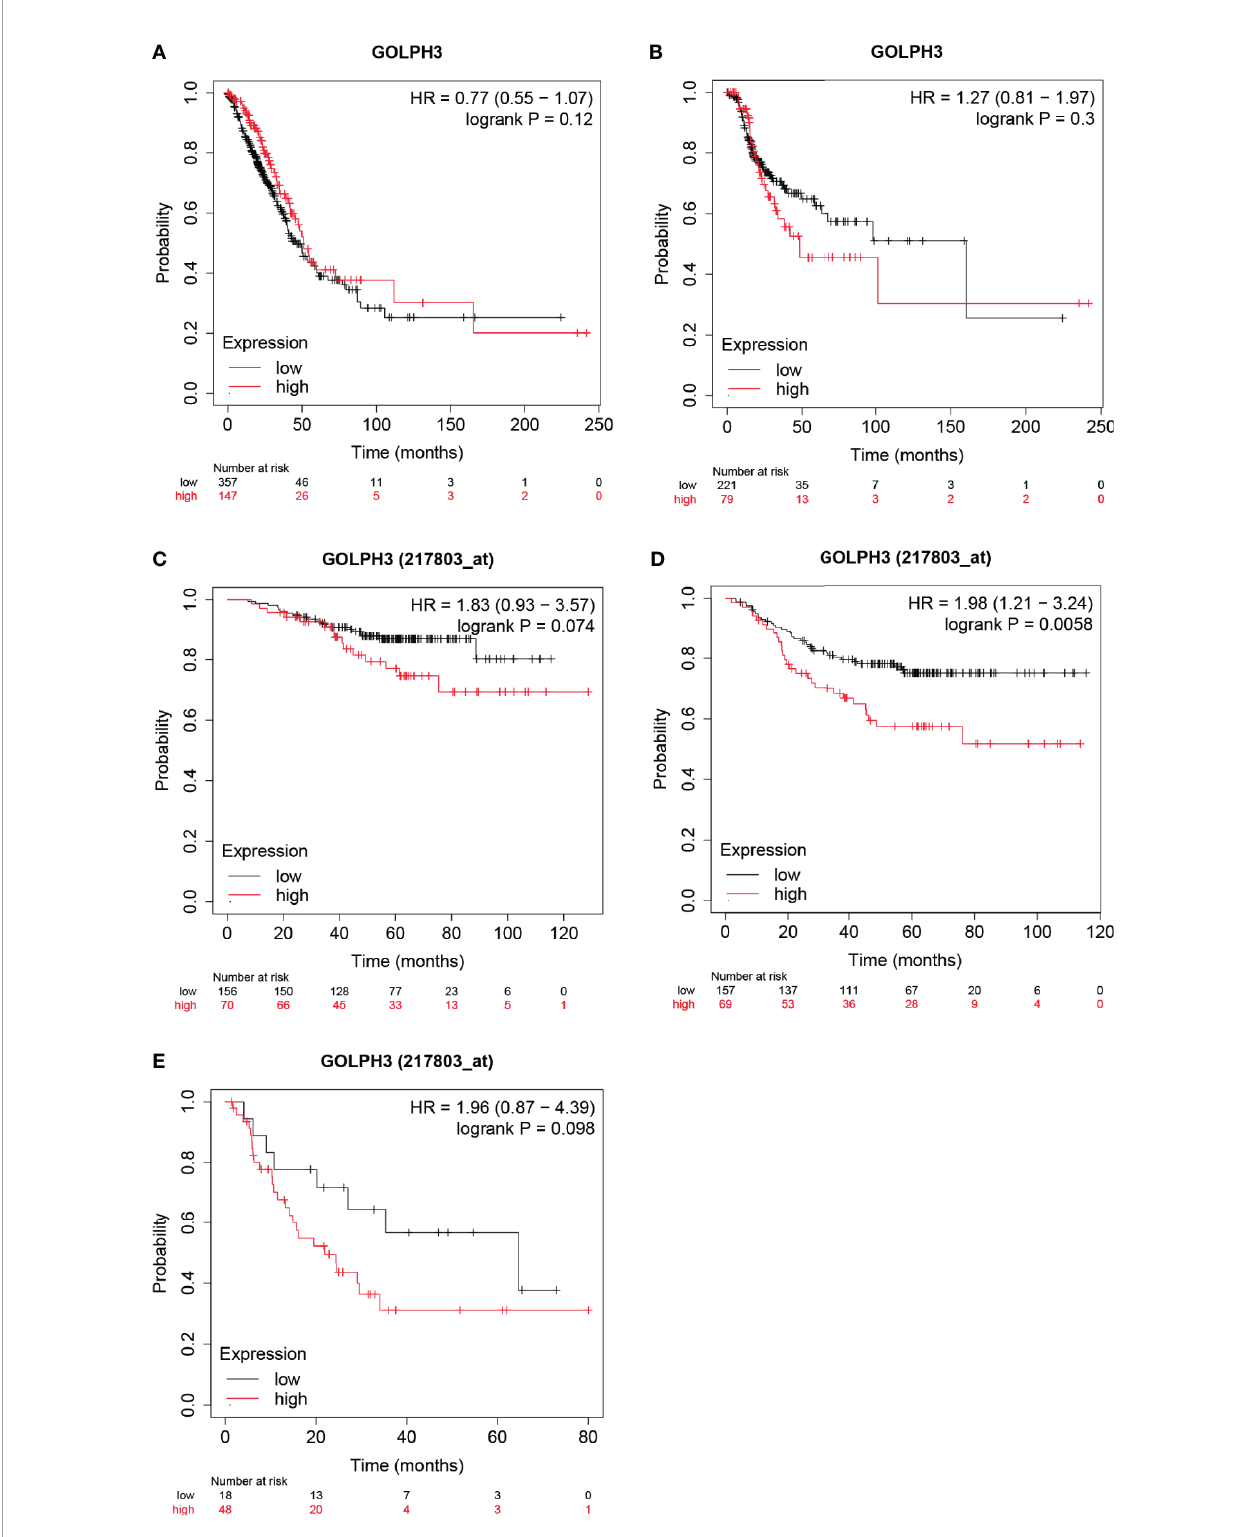
FIGURE 3 | Survival analysis of GOLPH3 (Kaplan – Meier plotter). (A) Overall survival (OS) in LUAD. (B) Relapse-free survival (RFS) in LUAD. (C – E) OS, fi rst progression (FP), and post-progression survival (PPS) in GSE31210 cohort, respectively. LUAD, lung adenocarcinoma. All results are available online.